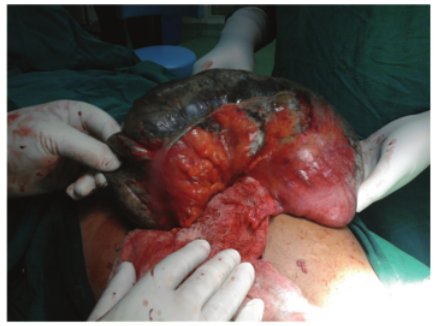
Figure 2: Surgical findings with gangrenous cecal